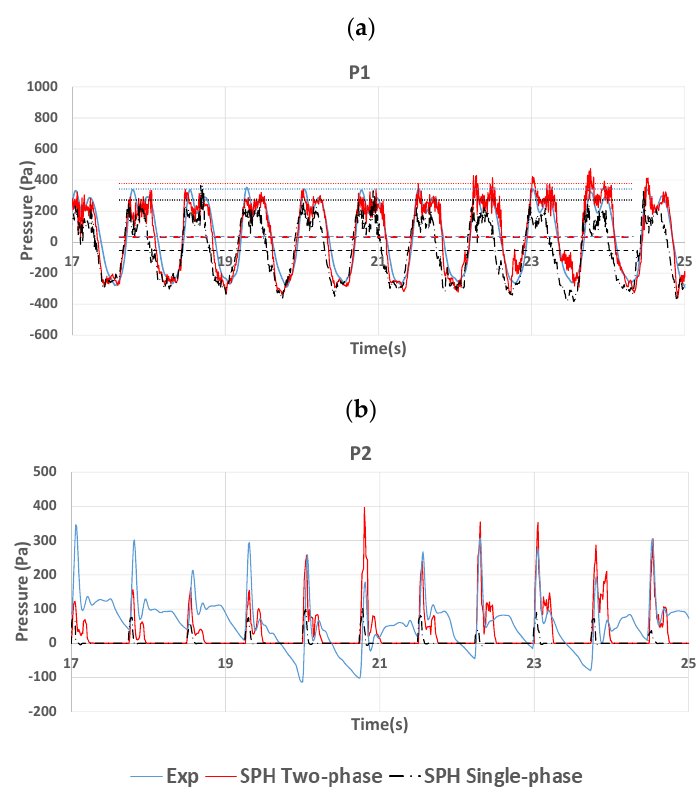
Figure 16. Comparison of pressures at ( a ) P1 and ( b ) P2 for sway oscillation with a filling ratio of 50%.